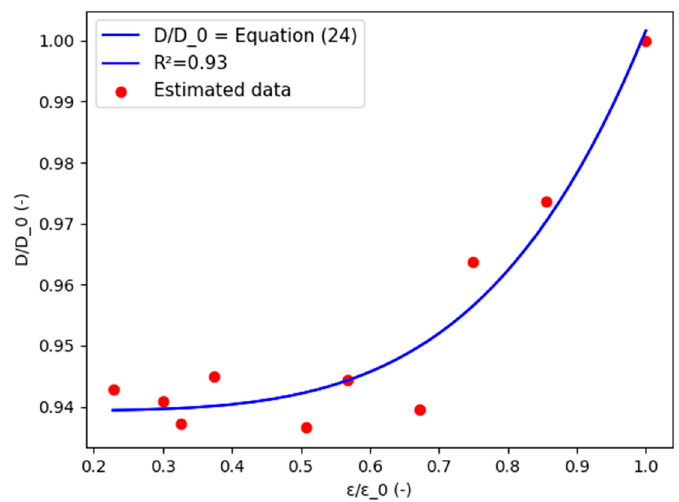
Figure 14. Variation of water vapor normalized diffusion coefficient with the compressed MCC PH101 powder tablet normalized porosity.